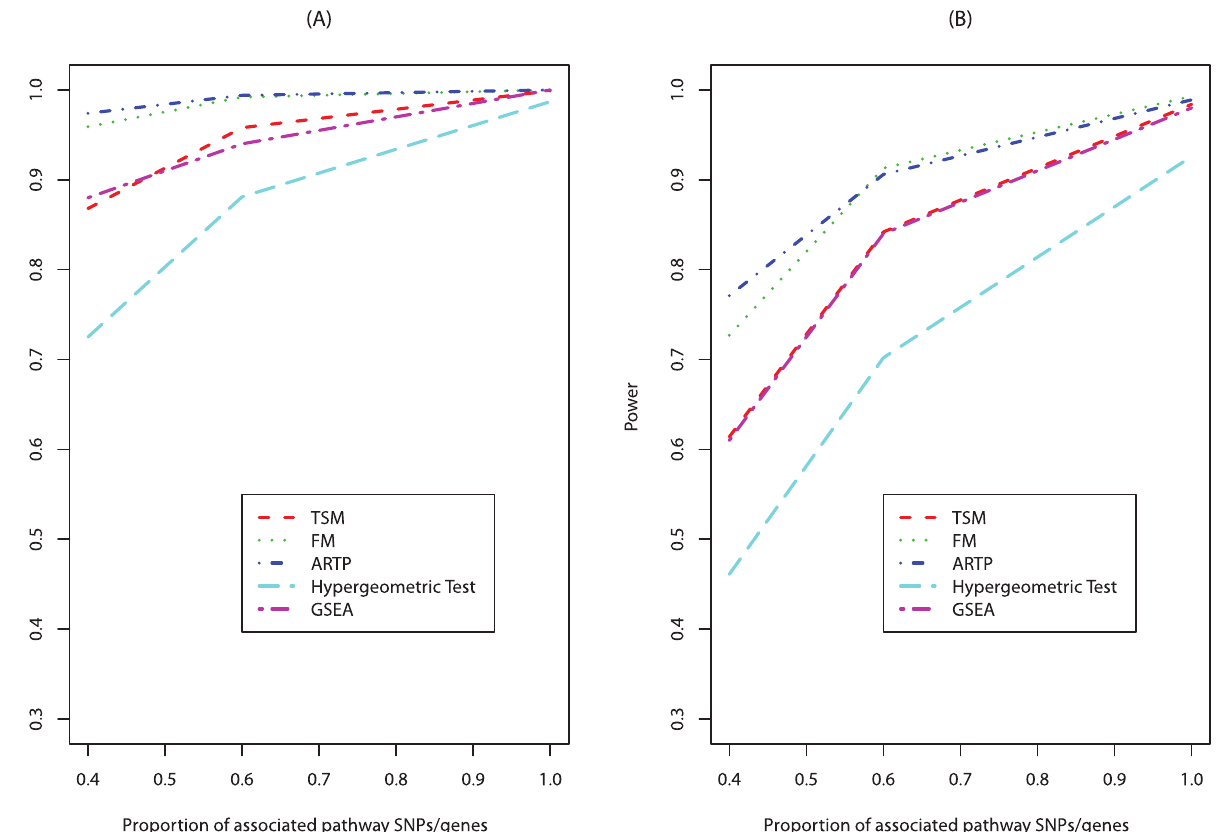
~ 4 and s 2 ~ 1 for p np